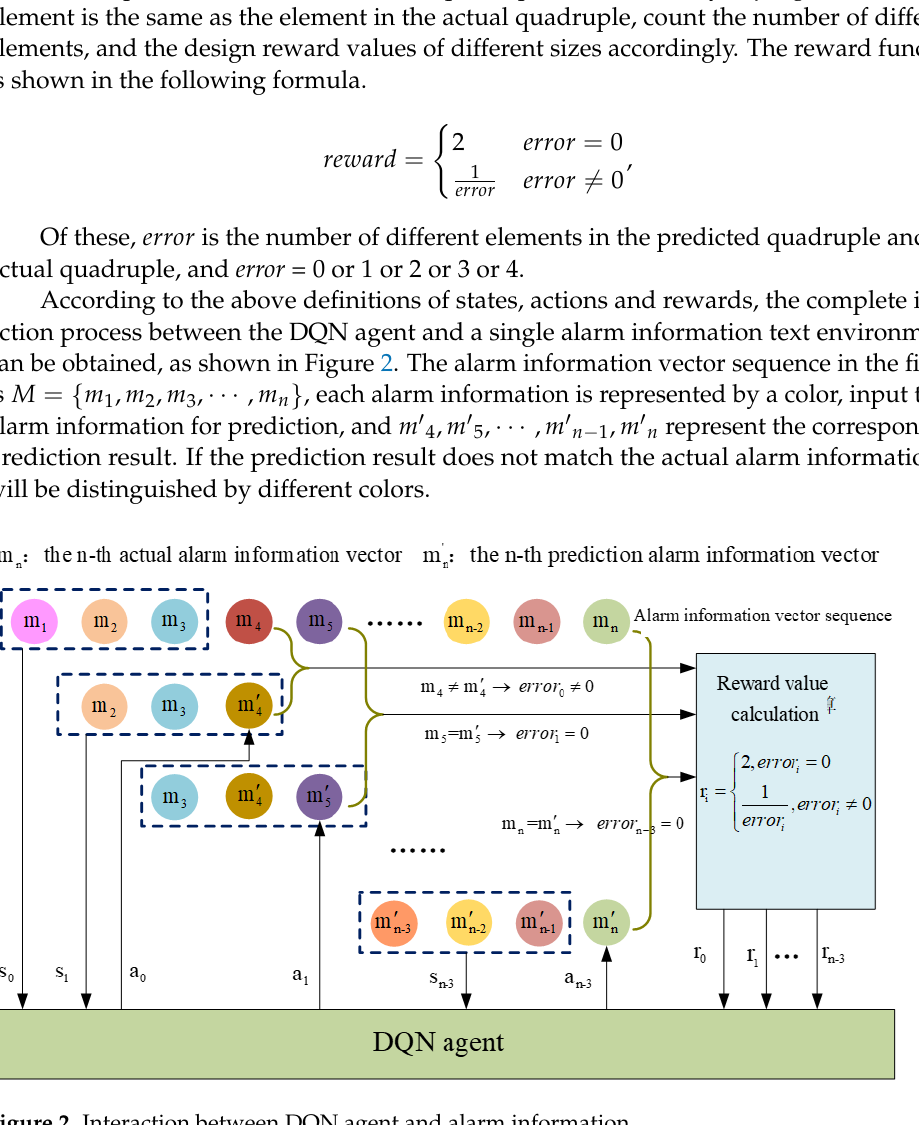
Figure 2. Interaction between DQN agent and alarm information.